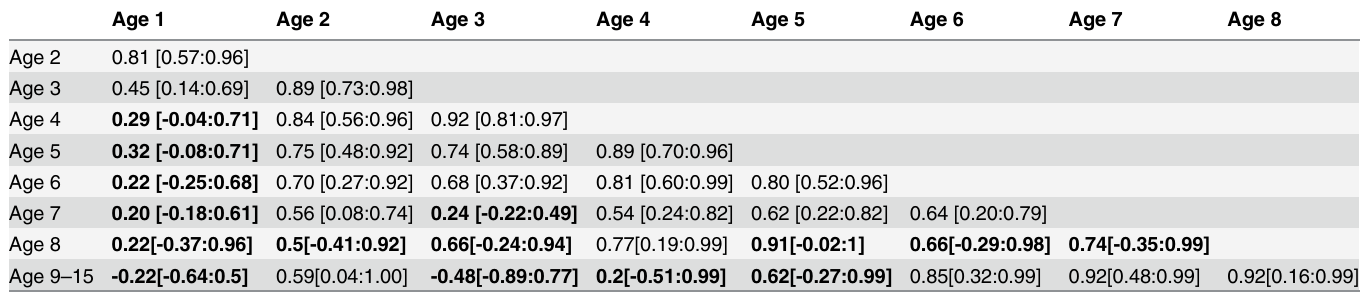
Table 7. Results of genetic correlations between age-classes for courtship display